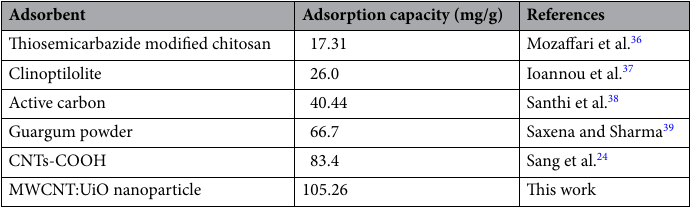
Table 4. Comparison of obtained experimental results for adsorption of MR dye on MWCNT1:UiO1